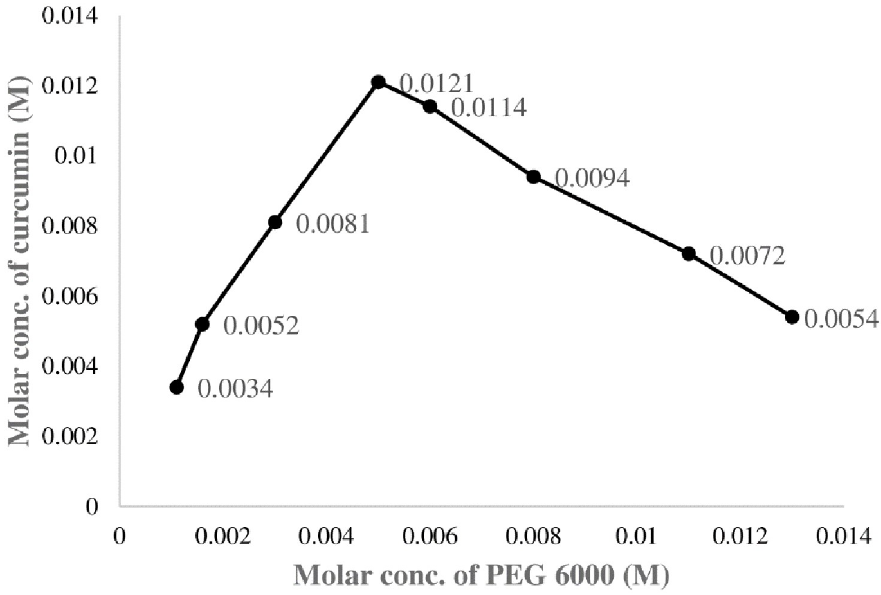
Fig 2. Phase solubility diagram of CUR in different molar concentrations of PEG 6000 and molar concentration of CUR showed that 3:1 PEG-CUR complex has maximum solubility of CUR represented as mean ± SD (n = 3).